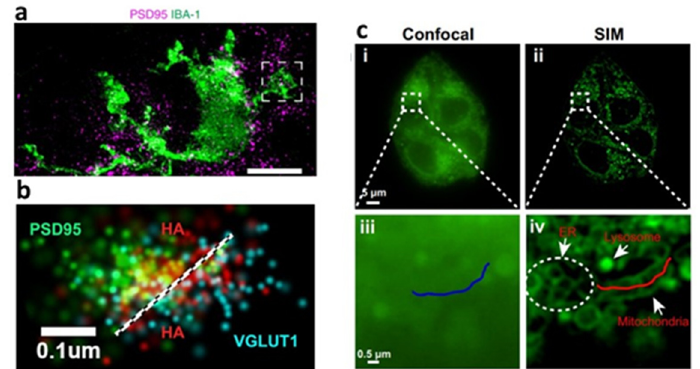
Figure 3. ( a ) STED microscopy showed the distribution of microglia (IBA-1) in relation to the postsynaptic marker PSD95 in cerebral organoids. Reproduced from Reference [92] under the Creative Commons License (CC BY 4.0); ( b ) STORM was used to visualize hyaluronan (HA) at individual excitatory synapses in 3D cortical spheroid (presynaptic marker vGlut-1, blue; HA, red; postsynaptic marker PSD95, green). Reproduced from Reference [140] under the Creative Commons License (CC BY 4.0); ( c ) Confocal ( i ) and ( iii ) and SIM ( ii ) and ( iv ) images for the NapBu-BPEA-stained (Zn2+